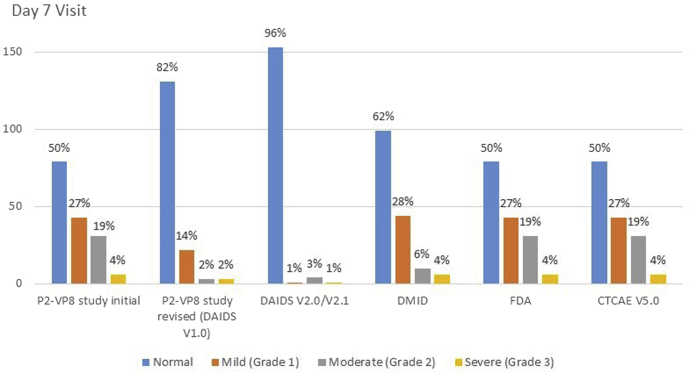
Grading of ANCs in healthy HIV-uninfected South African infants at day 7 after the first vaccination (n = 159) using different toxicity grading scales. There were no infants assessed as having life-threatening neutropenia using any of the grading scales. CTCAE, Common Terminology Criteria for Adverse Events Version 5.0 Nov 2017.